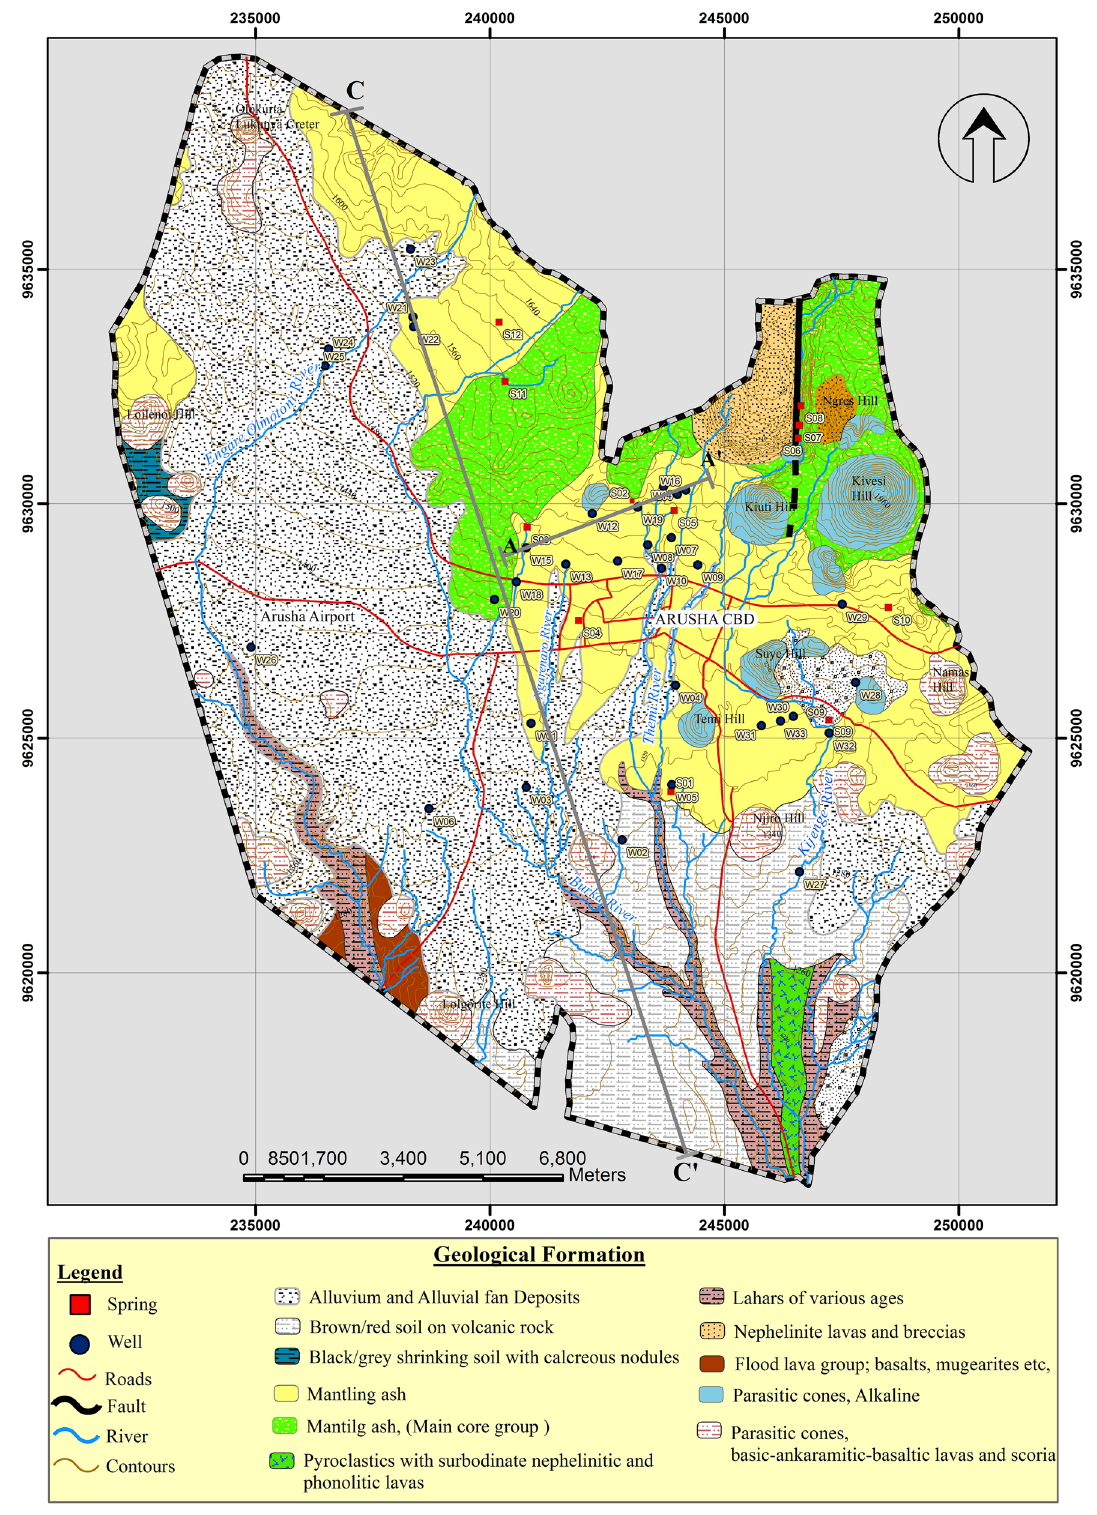
Fig. 2 Hydrogeological map showing location of sampling sites. Reproduced with permission form AA.VV.